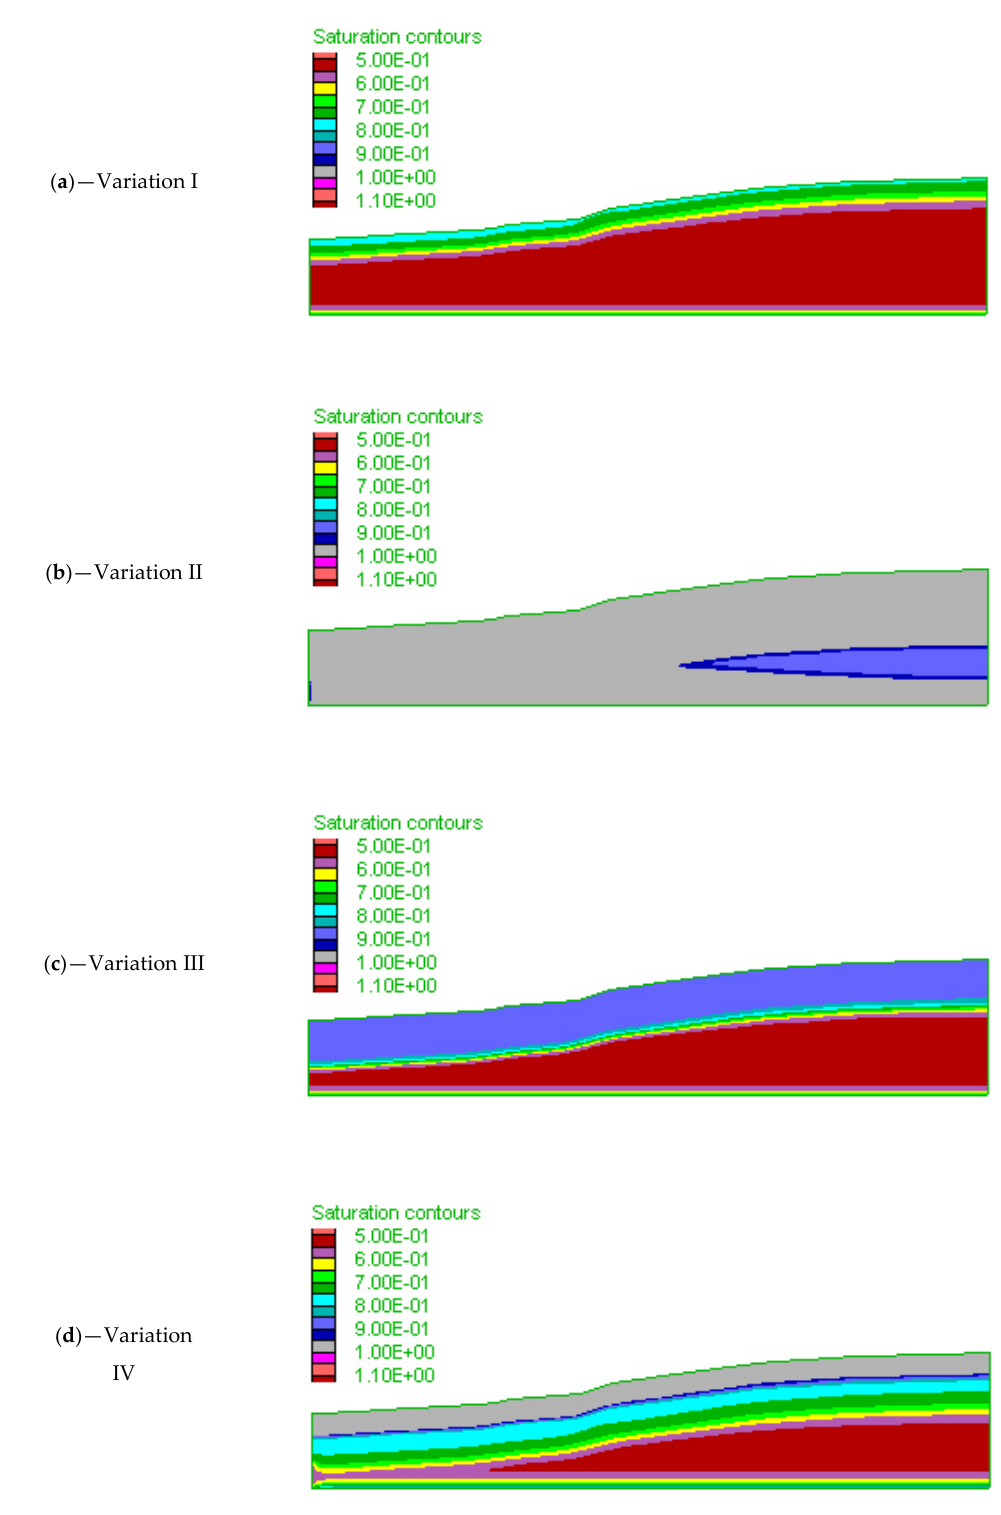
Figure 8. Model 2D and location of soil layers in slope.